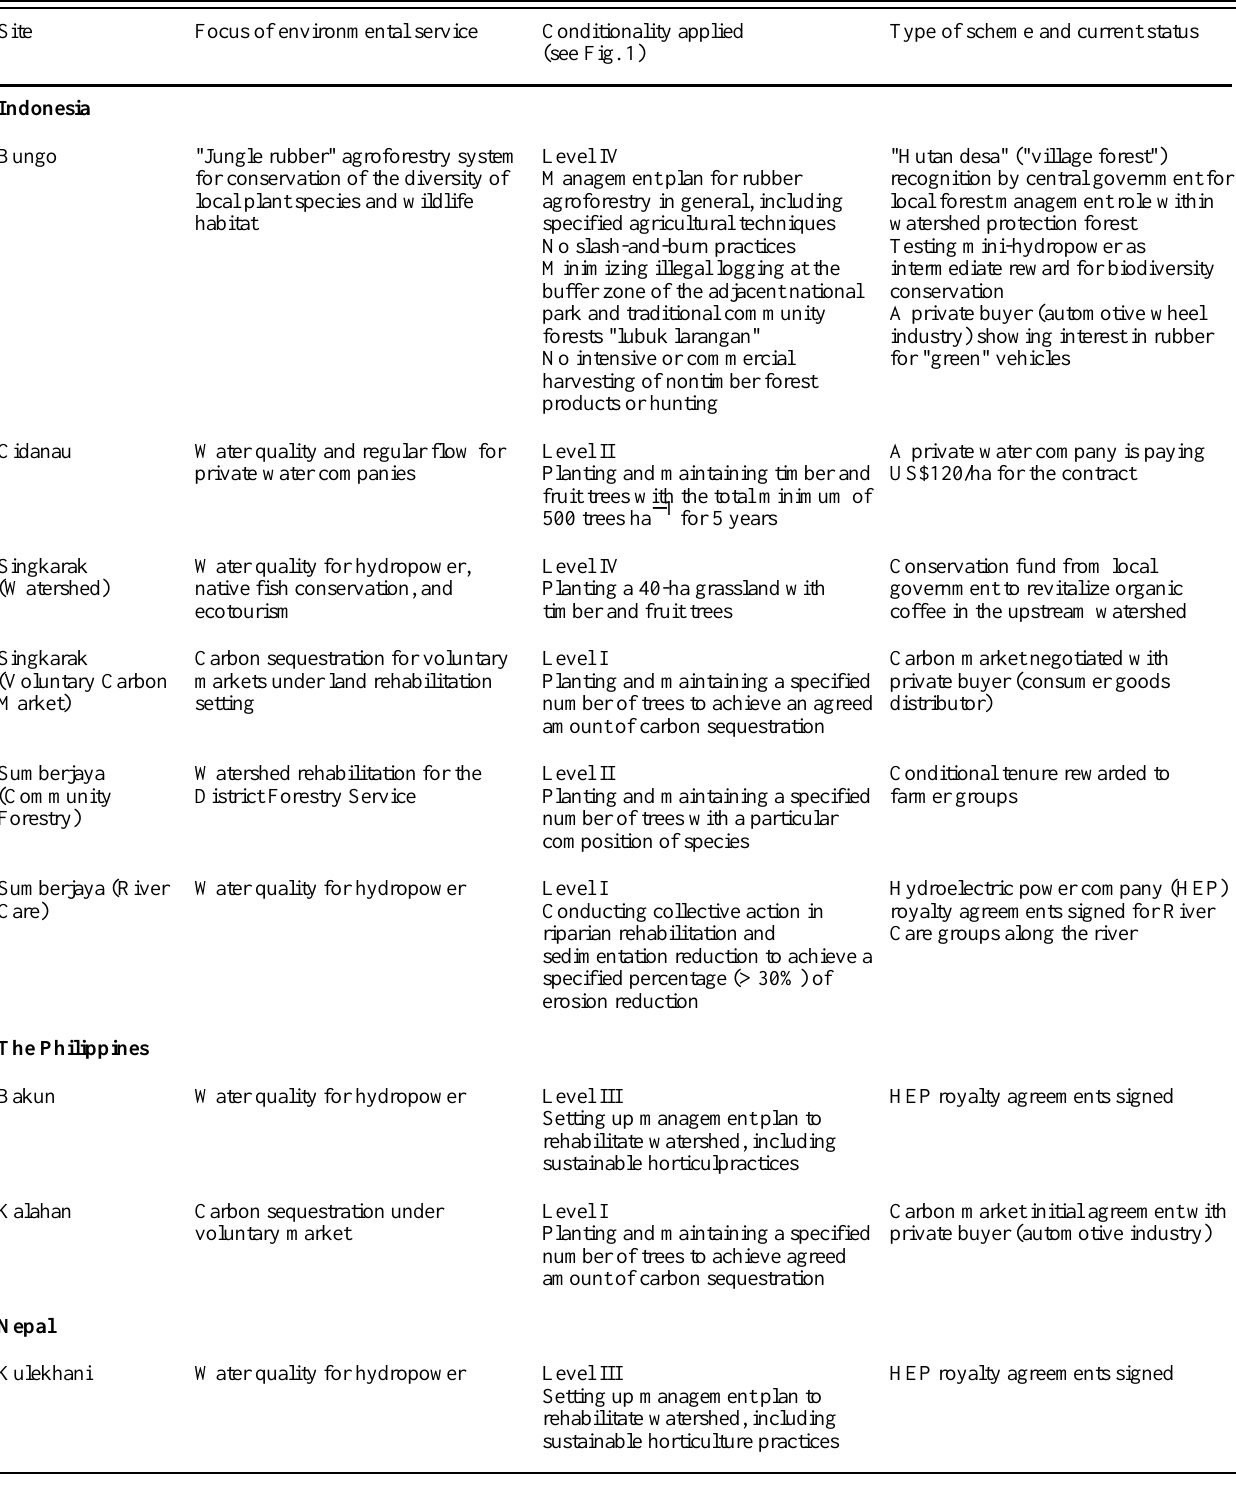
Table 1. Site level experience in the RUPES Phase I project in